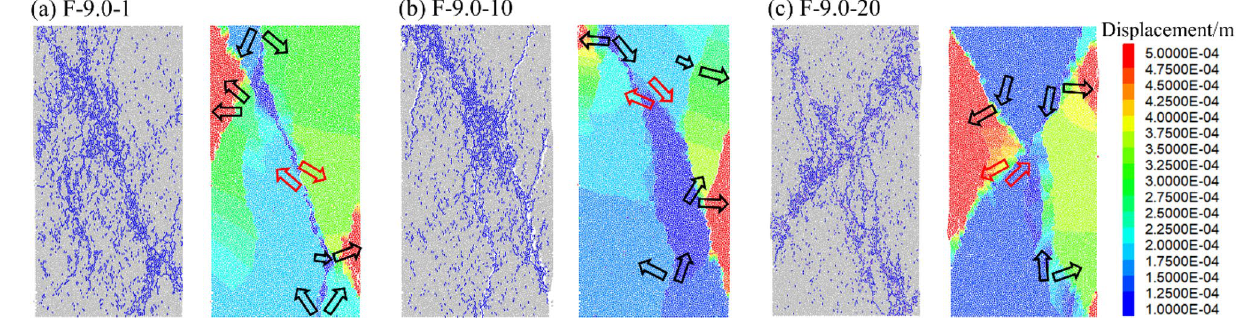
Figure 13. Crack distribution and displacement vector field of rock specimens ( A = 9.0 MPa).